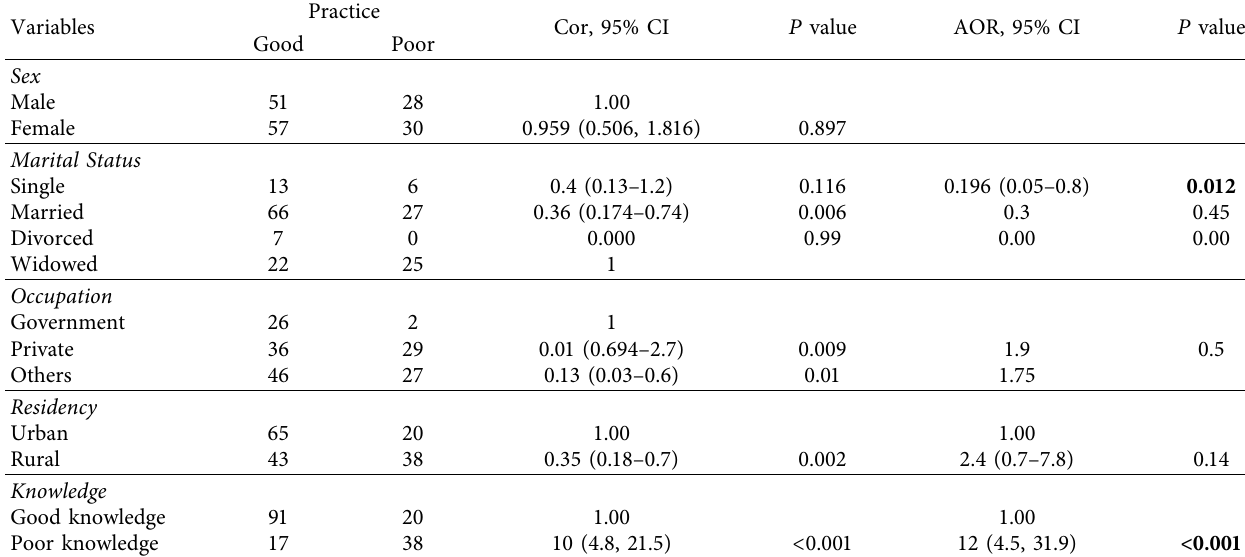
Table 4: Factors associated with practices towards MDI use in DMCSH,